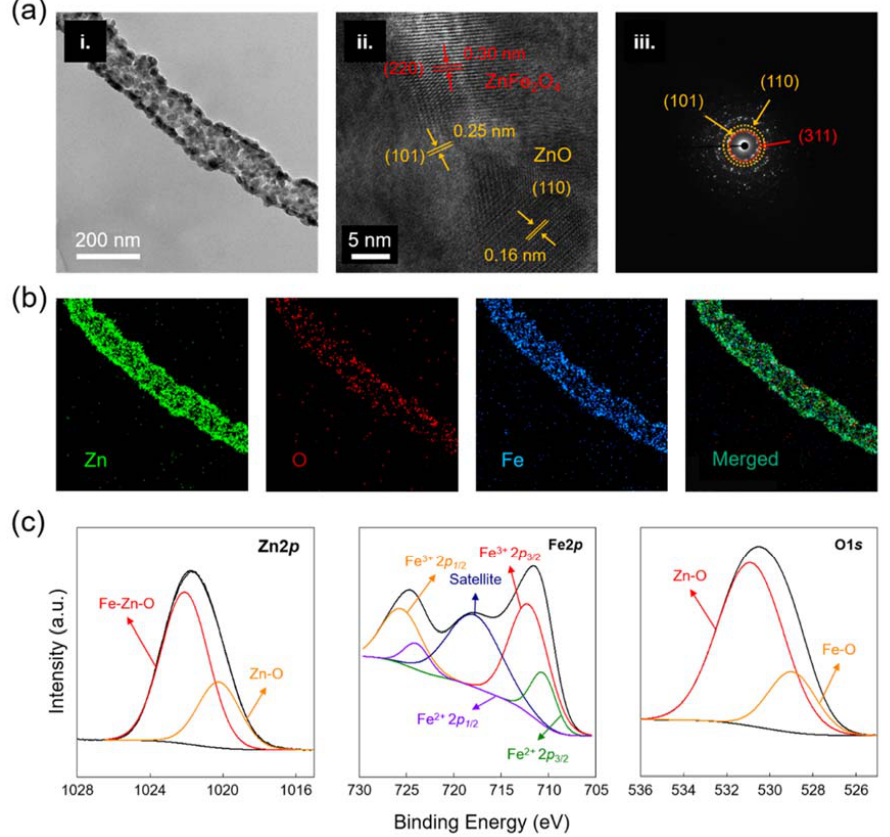
Figure 2. ( a ) TEM, HR-TEM, and SAED analysis results of the ZnO-ZnFe 2 O 4 hollow nanofiber after calcination at 600 ◦ C. ( b ) EDS mapping images of the ZnO-ZnFe 2 O 4 hollow nanofiber. ( c ) XPS spectra of ZnO-ZnFe 2 O 4 hollow nanofiber for Zn2p, Fe2p, and